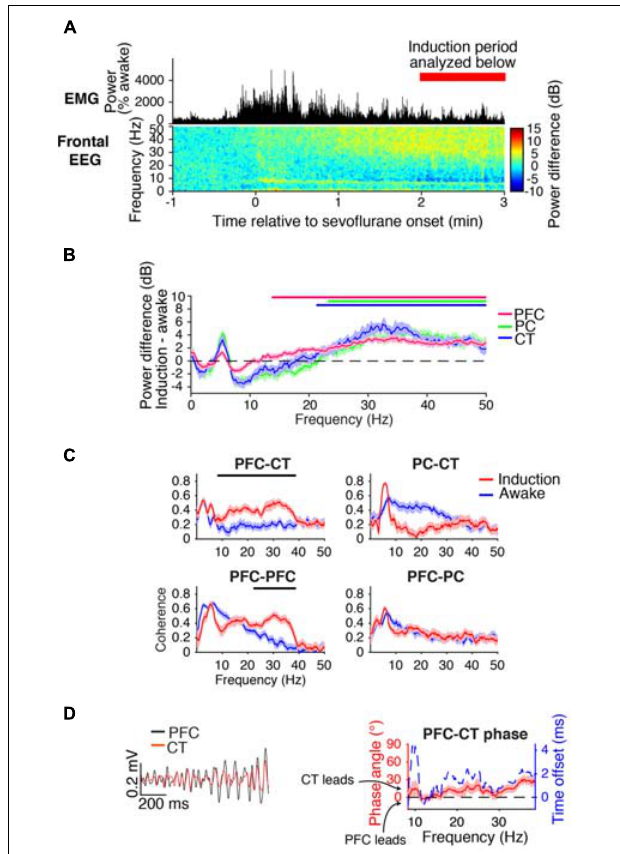
FIGURE 3 | Dynamics during induction. (A) Group EMG power and group difference spectrogram of the frontal EEG aligned to the start of sevoflurane administration. Red rectangle with text marks the period analyzed in (B–D) . (B) Group power difference for PFC (red), PC (green), and CT (blue) LFPs. Shading indicates 95% confidence intervals, and red, green, and blue horizontal lines mark ranges of significant power increase from awake baseline for PFC, PC, and CT LFPs, respectively. (C) Group coherence between LFPs during the 1.6% sevoflurane induction (red) and awake (blue) states. Shading indicates 95% confidence intervals, and horizontal lines mark ranges of significant coherence increase from awake baseline. (D) Left: PFC (black) and CT (red) LFPs from a representative animal filtered in the range of significant PFC–CT LFP coherence increase shown in (C) . Right: group PFC–CT LFP phase relationship in the range of significant PFC–CT LFP coherence increase shown in (C) , in terms of phase angle (left y -axis, red line) and time offset (right y -axis, blue dotted line). Shading indicates 95% confidence intervals for phase angle. A positive phase relationship indicates that the first signal lags the second at the indicated